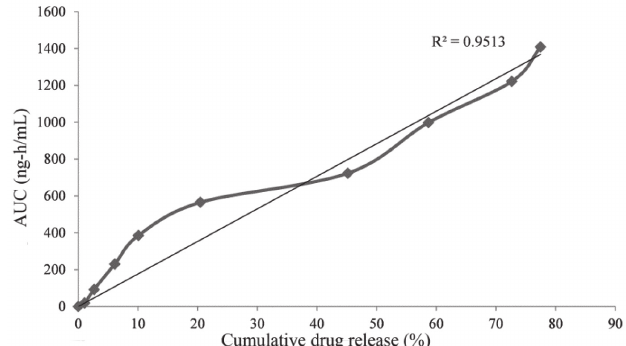
FIGURE 6 - In vitro-in vivo correlation plot of optimized tacrolimus-CSP.